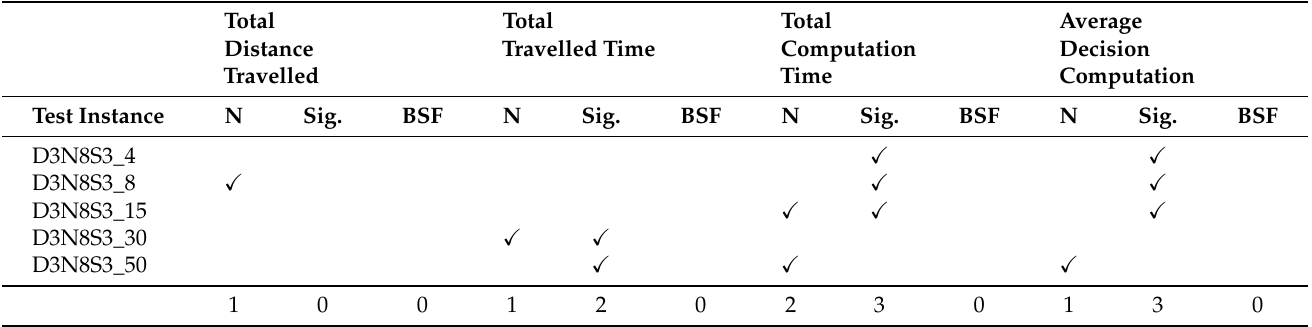
Table A4. PDS_RA performance with TBIH-3 application as base